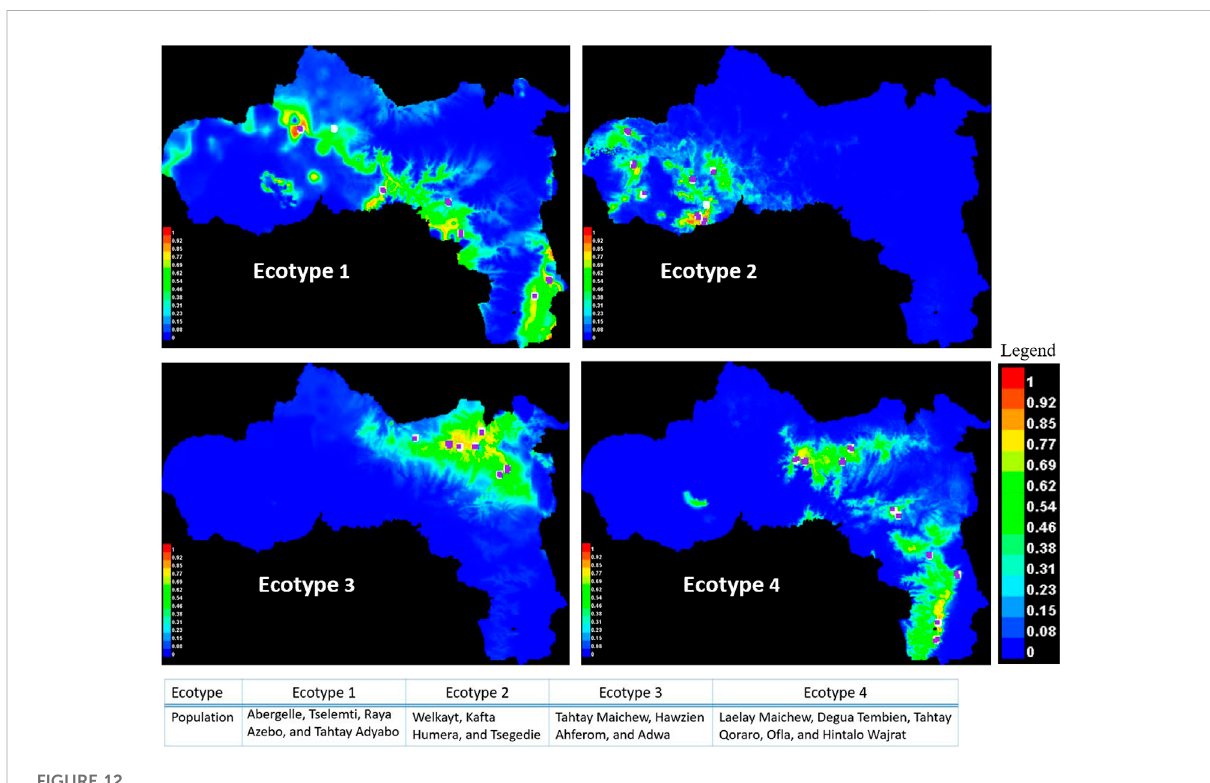
FIGURE 12 Suitability maps for Tigray chicken populations grouped by